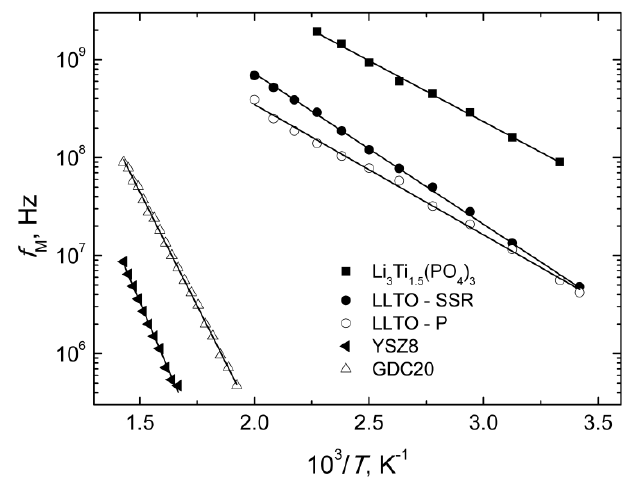
Figure 6: Arrhenius plot of Maxwell relaxation frequency